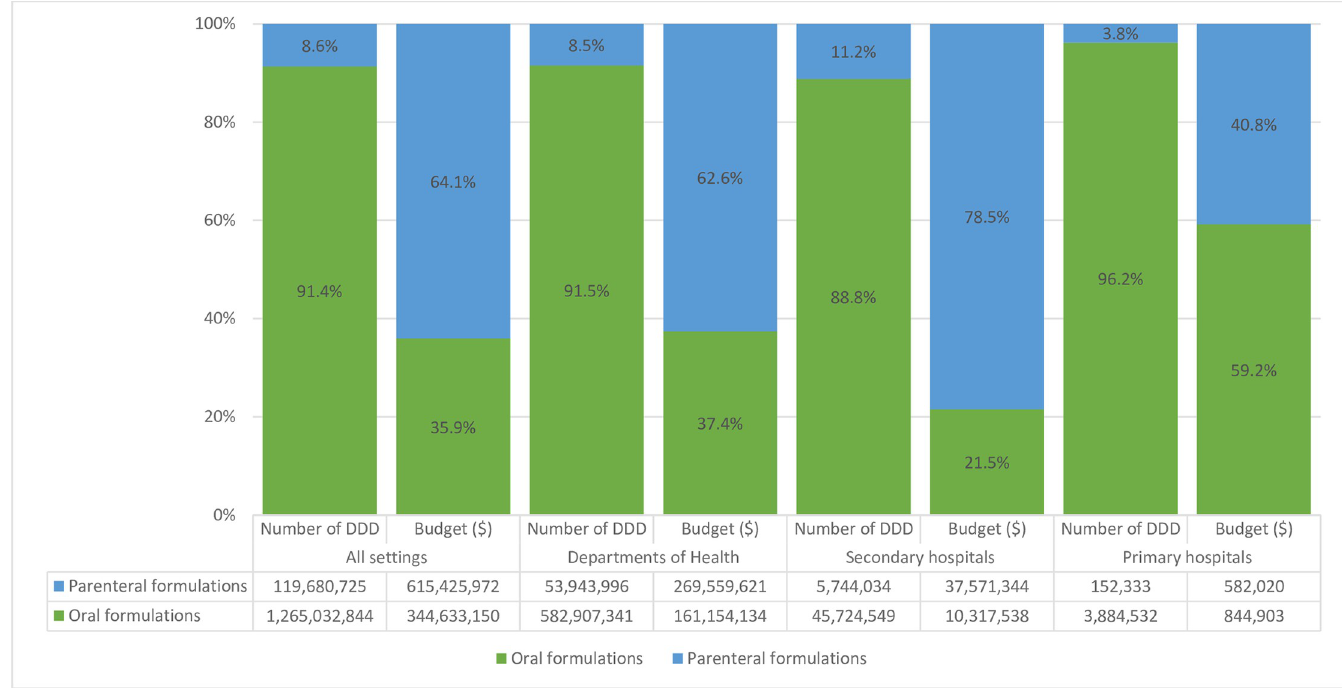
Fig 2. The proportion of bidding price and number of DDD of antimicrobials for systemic antibacterial (J01) by route of administration in hospitals in Vietnam.